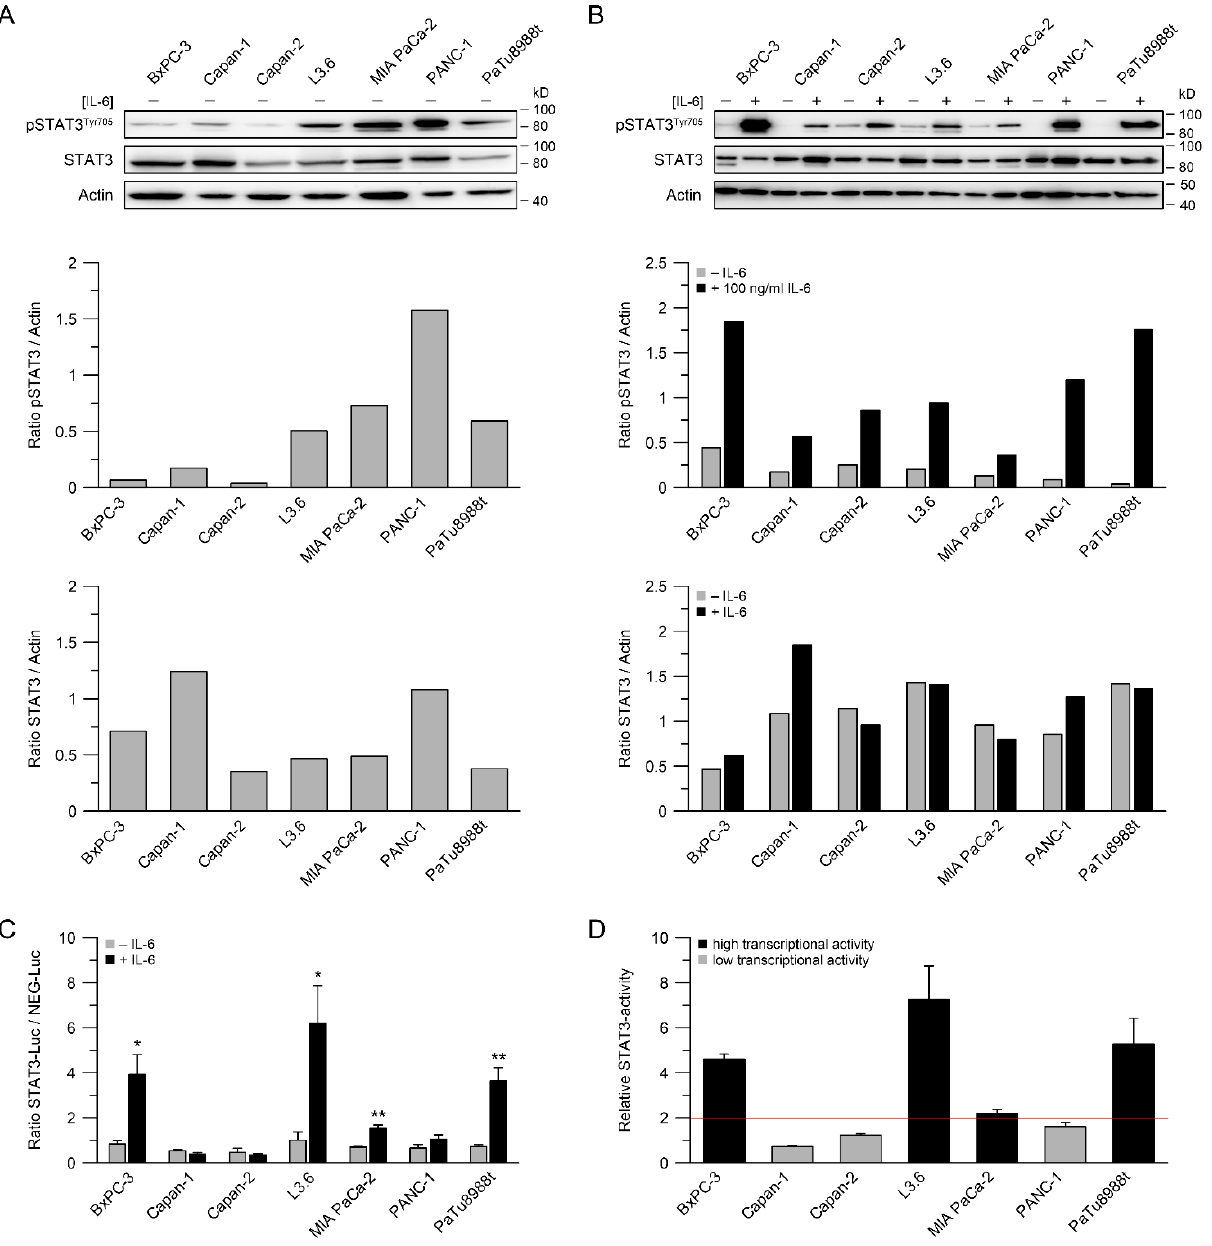
Figure 1. STAT3 expression and phosphorylation, and STAT3 transcriptional activity. ( A ) Seven pancreatic adenocarcinoma cell lines were analyzed for expression of STAT3 and levels of phosphorylated STAT3 (pSTAT3 Tyr705 ) by immunoblotting; ( B ) comparison of STAT3 and pSTAT3 Tyr705 protein levels after stimulation with interleukin-6 (IL-6; 100 ng/mL); ( C , D ) analysis of STAT3 transcriptional activity with and without stimulation with IL-6, displayed as STAT3/NEG-luciferase ratio ( C ), or relative STAT3 transcriptional activity ( D ), measured by dual luciferase reporter assays. Data are presented as mean ± s.e.m. from at least n = 3 independent biological replicates. * p < 0.05, ** p < 0.01, unpaired two-sample Student’s t -test. For p -values, see Table S1.